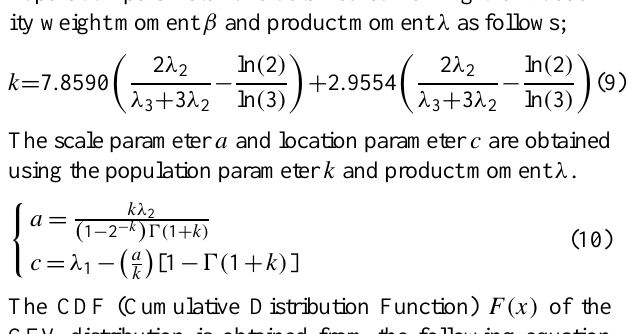
Figure 2. Distribution of the annual maximum daily rainfall